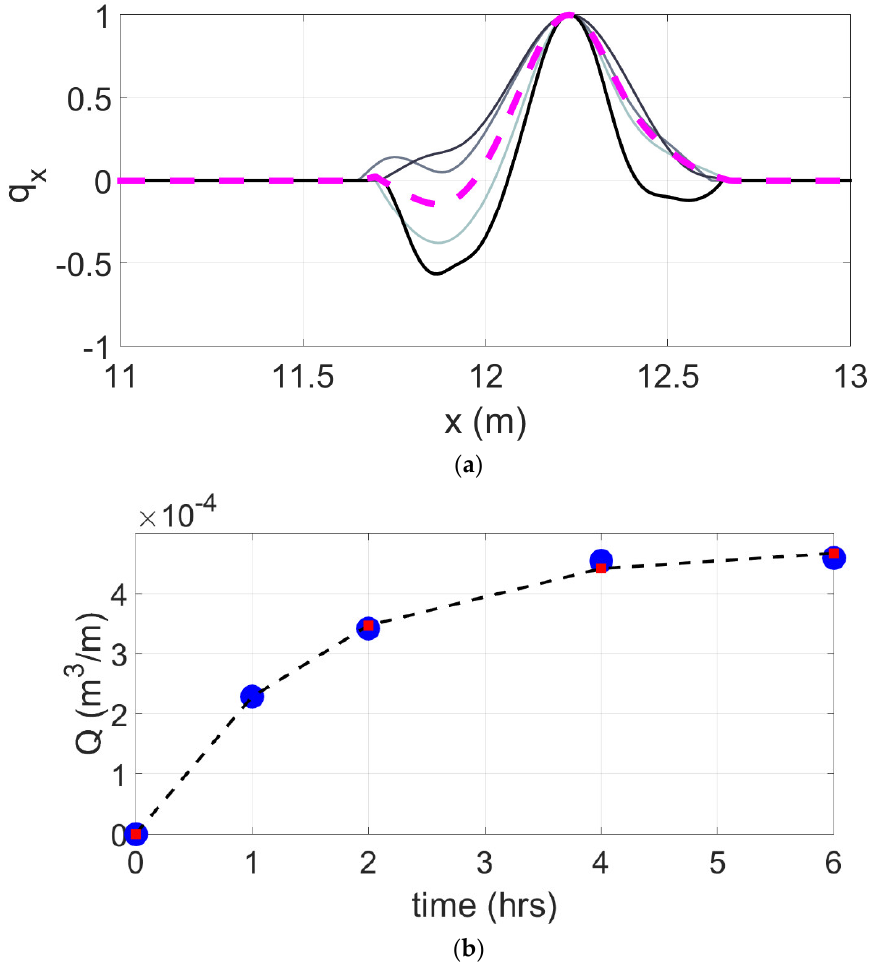
Figure 12. ( a ). Local sediment transport as presented in Figure 11a, centred and normalized ac- cording to the peak in transport, together with the mean transport pattern (dashed magenta line). ( b ) Cumulative net bulk sediment transport, Q, versus time for data (dots) and equilibrium model. For modelling purposes, the transport Q is first fitted to the exponential-based law Q eq (1 − exp( − t/ τ )), with Q eq = 5.10 −4 m 3 /m and τ = 1.54 h, and discretised with dt = 2 h.